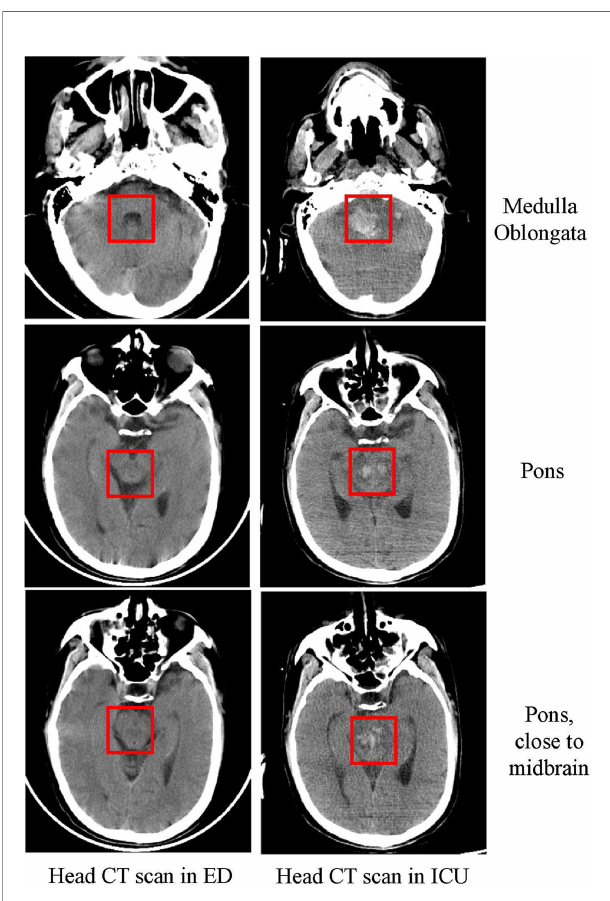
FIGURE 2 | Head CT scan in the ED and ICU. Head CT scan showing that as the disease progressed within fi ve days, the patient had extensive bleeding from the medulla oblongata to the pons as marked in the fi